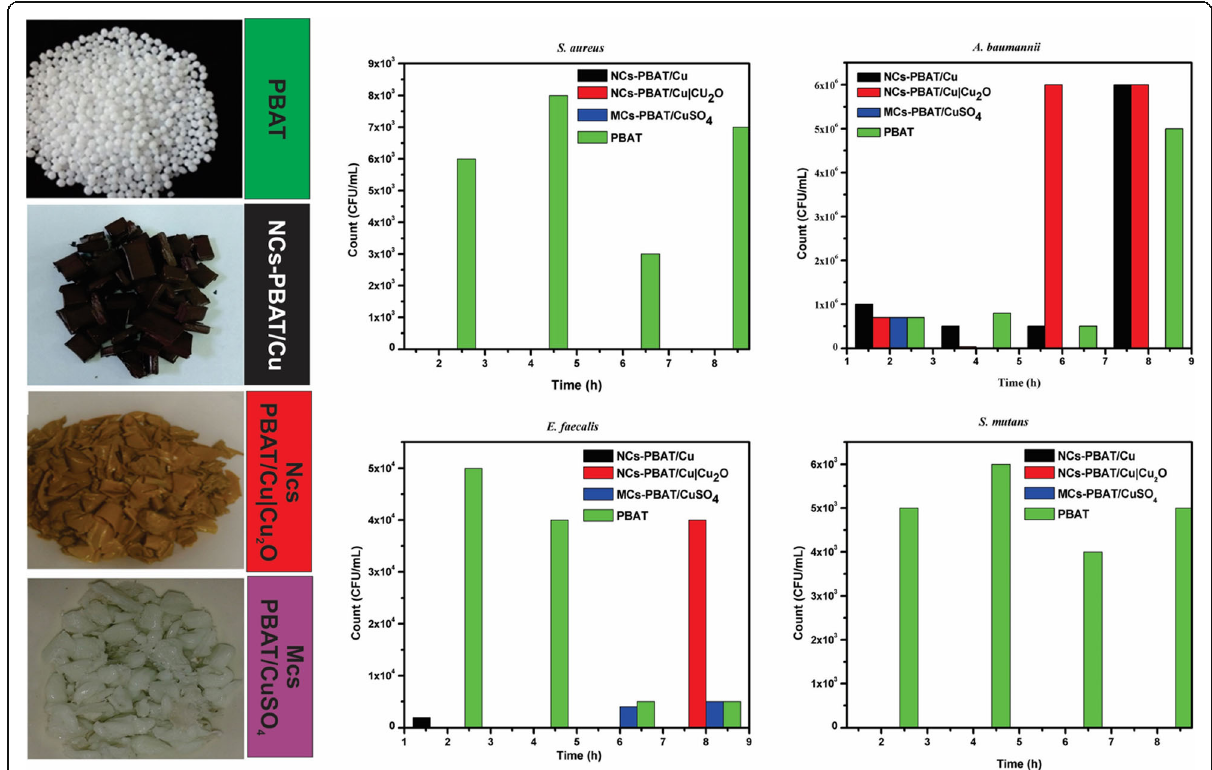
Fig. 5 Bacterial activity and colonization count PBAT, NCs-PBAT/Cu-3%, NCs-PBAT/Cu|Cu 2 O 3%, and MCs-PBAT/CuSO 4 3% for each strain of bacteria. Staphylococcus aureus , Acinetobacter baumanni , Enterococcus faecalis , Streptococcus